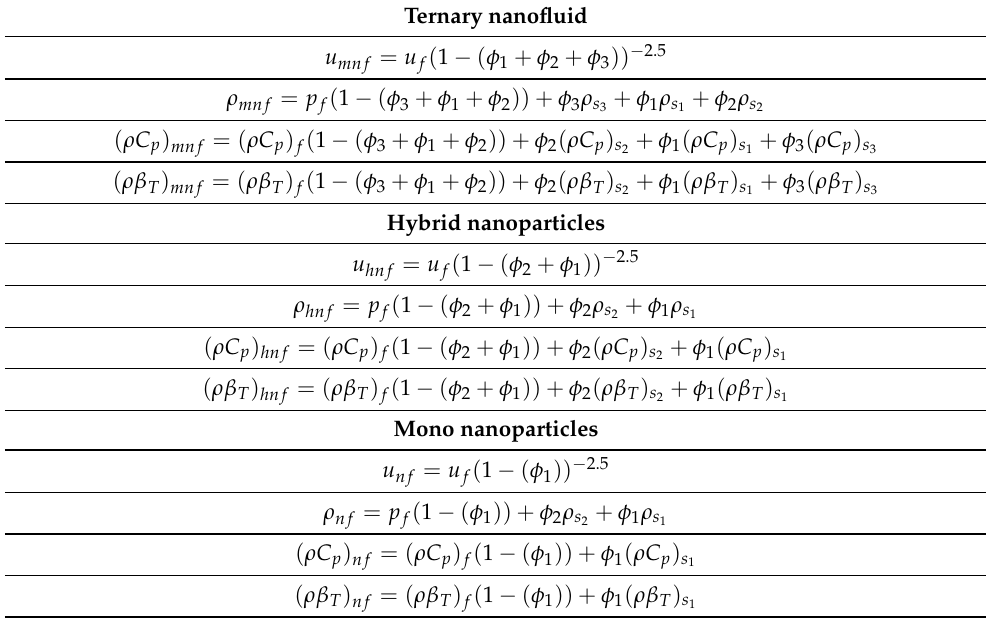
Table 2. Properties of mono, hybrid, and ternary nanoparticles [12]. Ternary